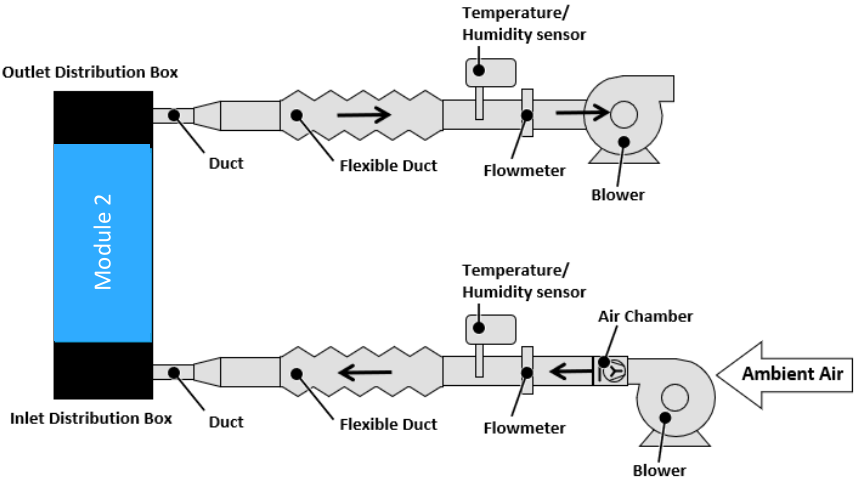
Figure 7. Outdoor experimental setup schematic.